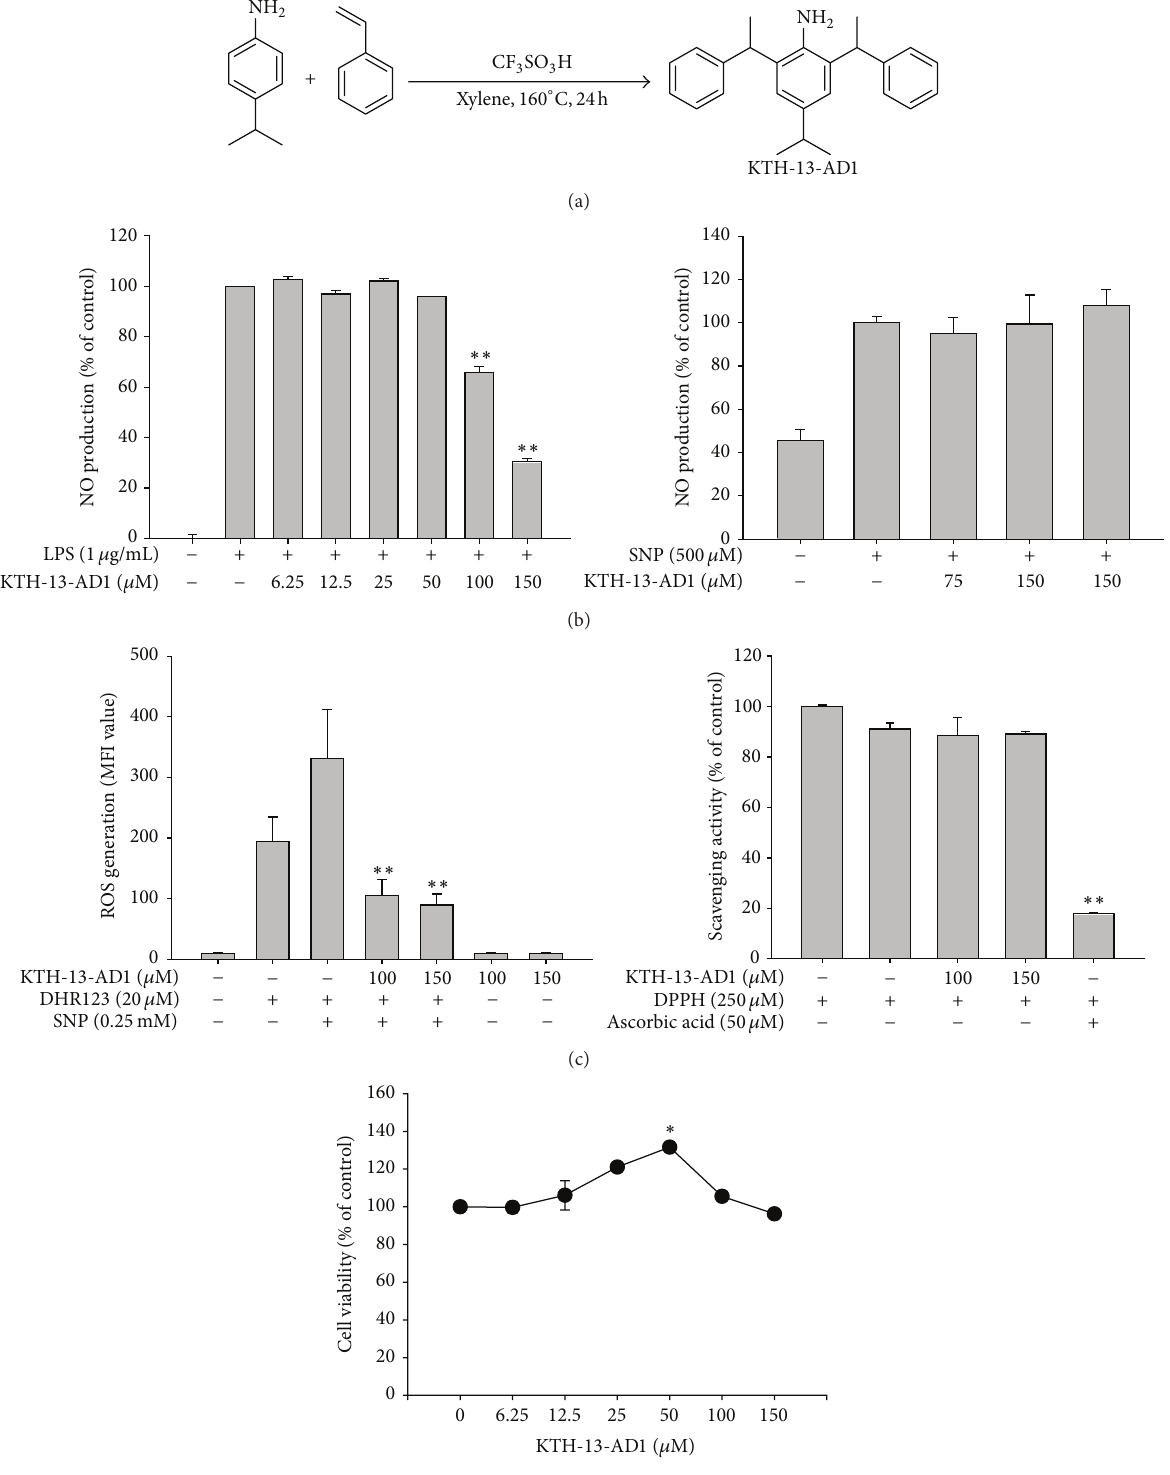
Figure 1: Effects of KTH-13-AD1 on macrophage-mediated inflammatory responses. (a) Chemical structure of KTH-13-AD1. (b) NO production in LPS-treated RAW264.7 cells or induced by sodium nitroprusside (SNP), as determined by Griess assay. ((c), left panel) The ROS scavenging effect of KTH-13-AD1 was measured with SNP (0.25 mM)-treated RAW264.7 cells, using DHR123 (20 𝜇 M). The level of ROS was determined through flow cytometric analysis. ((c), right panel) The radical scavenging activity of KTH-13-AD1 was determined using DPPH (250 𝜇 M) assay. (d) The effect of KTH-13-AD1 on the viability of RAW264.7 cells was evaluated using MTT assay. ∗ 𝑃 < 0.05 and ∗∗ 𝑃 < 0.01 compared to the vehicle control or normal